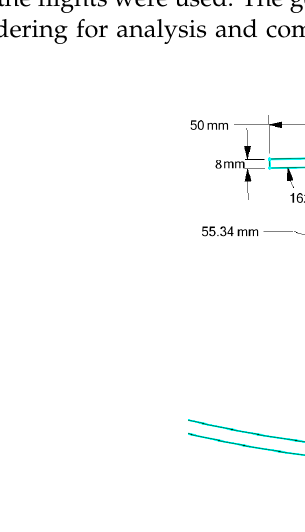
Figure 1. The geometrical characteristics of the real model used in the analysis: ( a ) flights’ arrange- ment inside the drum, ( b ) the shape and dimensions of the flights.